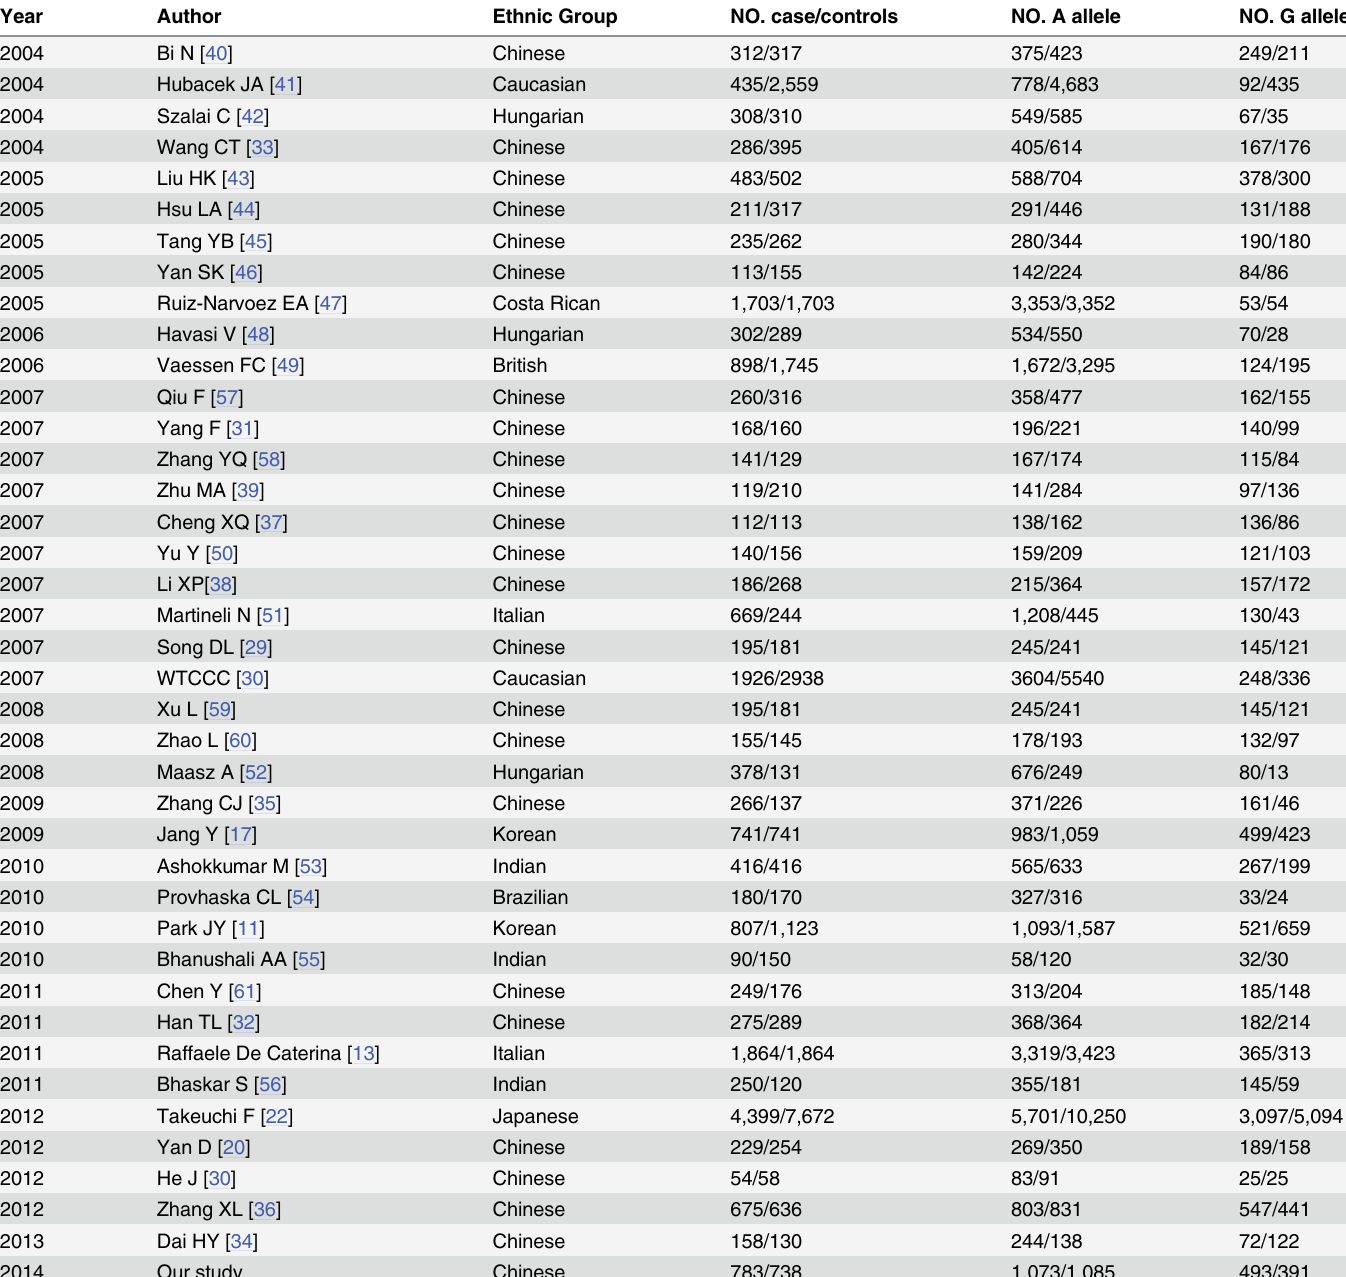
Table 3. Detailed information of the APOA5 rs662799 cases included in the